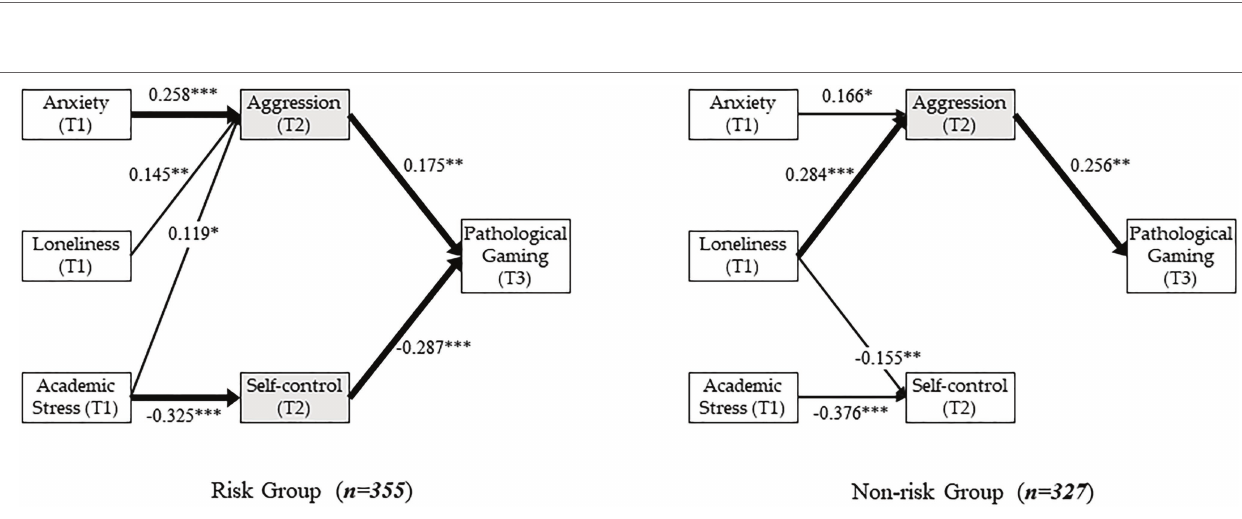
FIGURE 2 | Results of hypothesis test and mediation effect analysis. One asterisk (*) indicates p < 0.05, two asterisks (**), p < 0.01, and three asterisks (***), p < 0.001. Solid line indicates statistical significance. Bold line represents both statistical significance and significant indirect effect pathways. No link is statistically